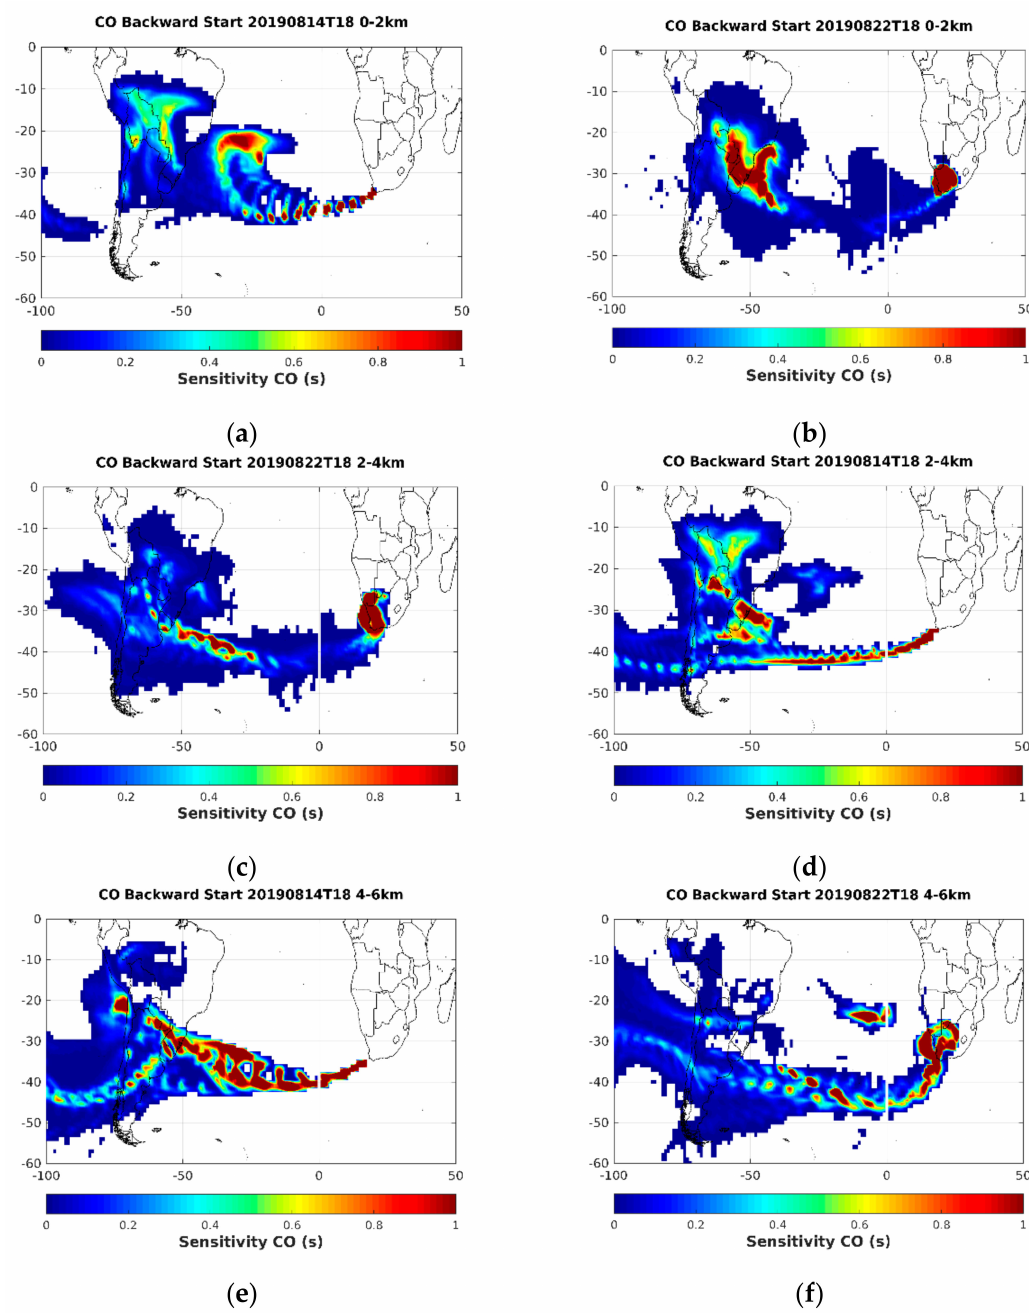
Figure 9. FLEXPART backward dispersion in terms of CO Emission Sensitivity for the two events. Simulations of event-1 (8 -14 August) are on the left panels, while simulations of event-2 (14–22 August) are on the right panels. Both simulations were made at consecutive atmospheric layers: ( a , b ) at 0–2 km (upper), ( c , d ) at 2–4 km (intermediate), ( e , f ) at 4–6 km